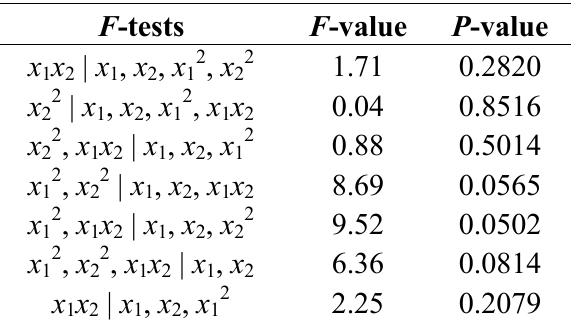
Table 1. F tests and corresponding p